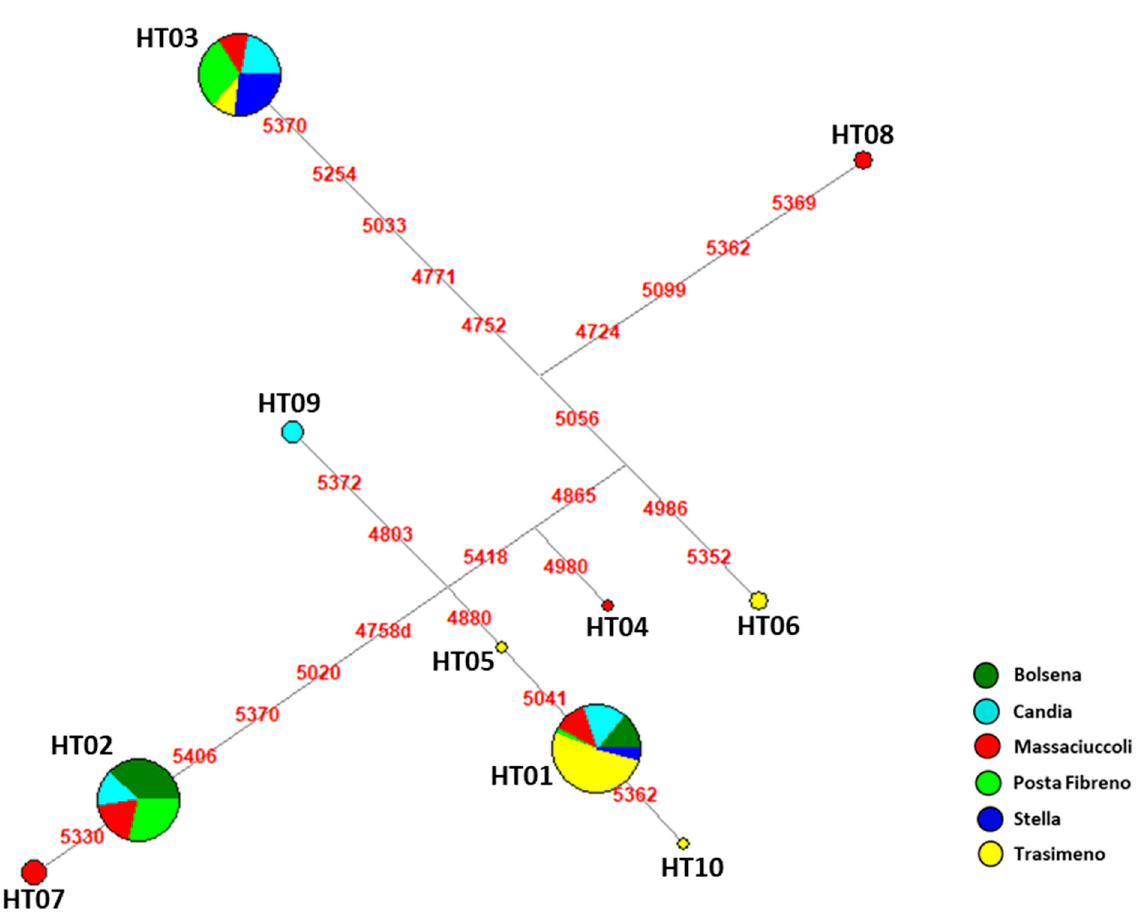
Figure 1. Median-Joining Network based on 153 control-region sequences (nps 4717–5434) belonging to six P. clarkii populations from Italy. Circles represent the haplotypes and are proportional to the observed frequency in 153 samples (Table S2), while colors indicate the different basins: Bolsena (dark green), Candia (light blue), Massaciuccoli (red), Posta Fibreno (light green), Stella River (blue) and Trasimeno (yellow).